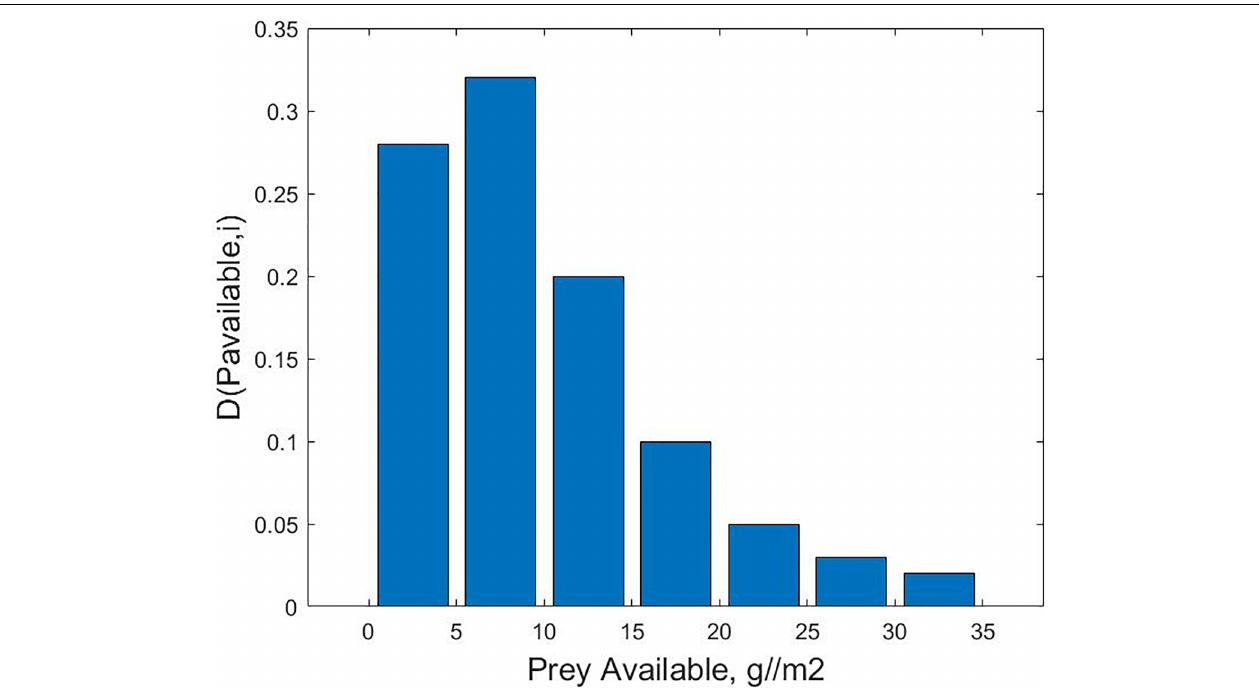
FIGURE 2 | Hypothetical probability density distribution for maximum available prey density, D (cid:0) P available , i (cid:1) (grams fish biomass per square meter).